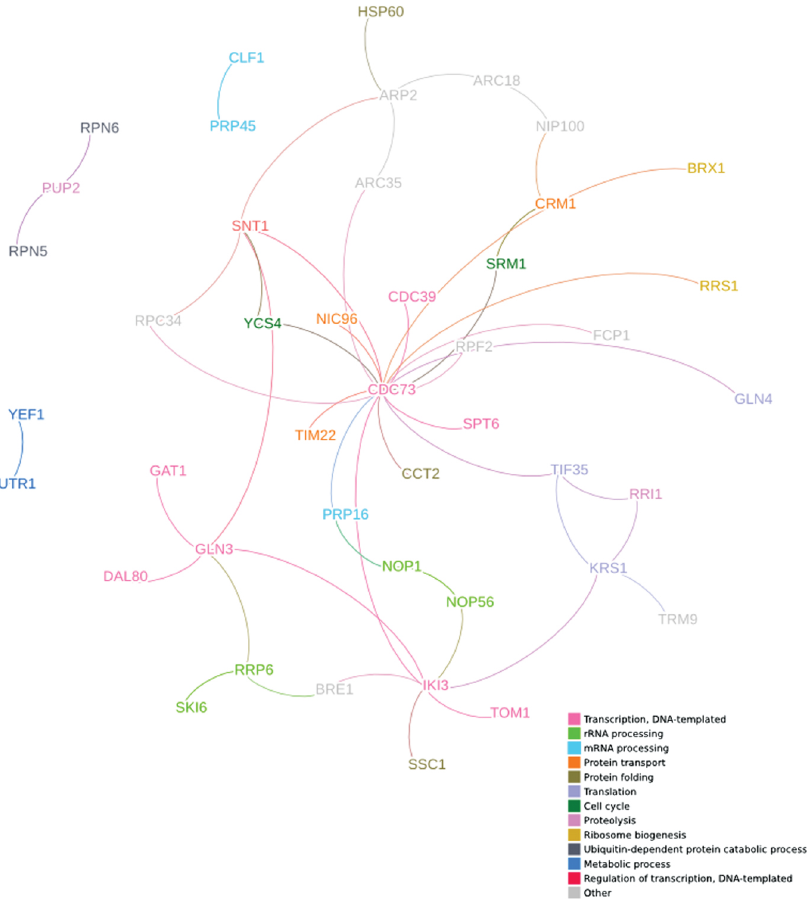
Figure 2: A genetic interaction network of S. cerevisiae DDR genes coloured by GO terms using genetic interaction data collected from BioGRID and filtered for orthologues of known human DDR genes. GO terms were sourced from the Gene Ontology Consortium and filtered for functional terms only. The most popular overall GO term was chosen for genes with multiple